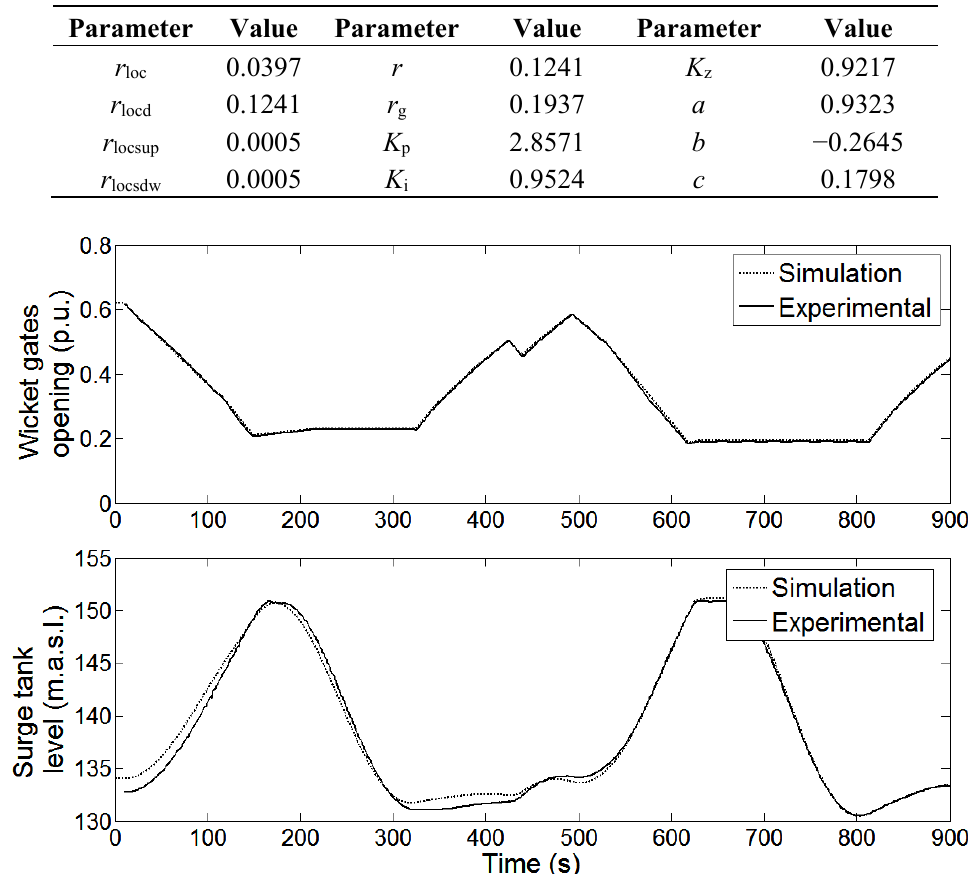
Figure 5. Comparison of recorded and simulated wicket gate opening and surge tank water level (on-site Test